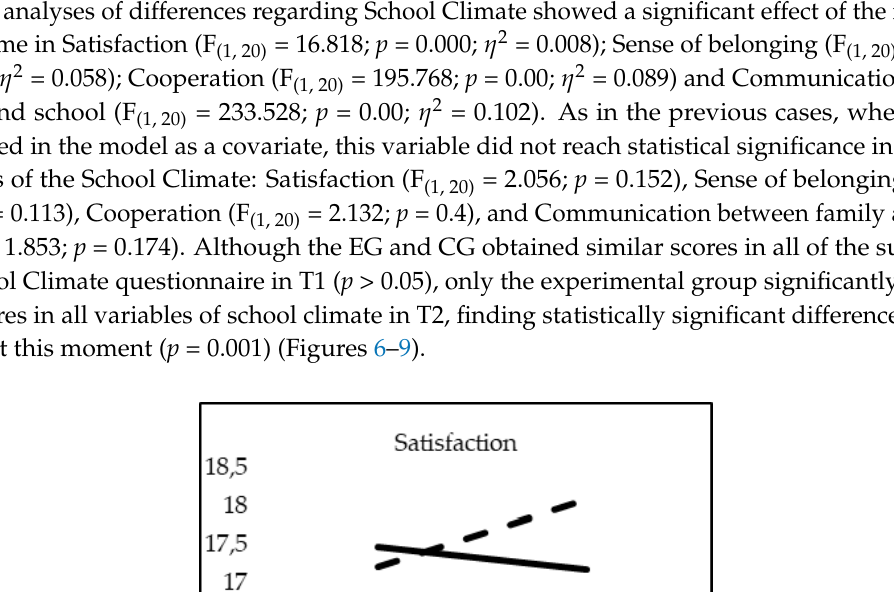
Figure 5. Interaction effects of group (EG-CG) and time (T1-T2) in Cybervictimization (E-Victimization Scale).